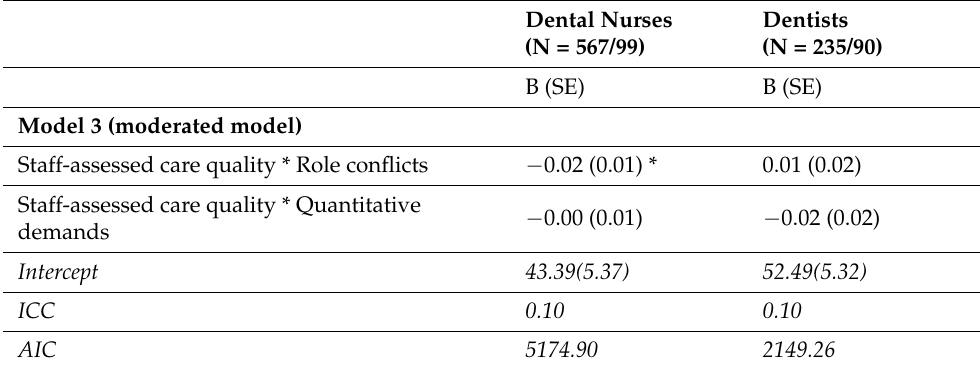
Figure 3. The conditional impact of role conflict on stress by staff-assessed care quality for dental nurses. Overall, the results of our analyses showed that individually rated quantitative de- mands and role conflicts were positively correlated and staff-assessed care quality at the clinic was negatively correlated with stress among dental professionals, confirming our Hypotheses 1a, 1b and 2. Moreover, the staff-assessed care quality at the clinic only miti- gated the association between individually rated role conflicts and stress among dental nurses, thus partially supporting Hypothesis 3b and rejecting Hypothesis 3a. For an over- view of the hypotheses and results, see Table 4. Table 4. Results of the hypotheses for dentists and dental nurses. Model